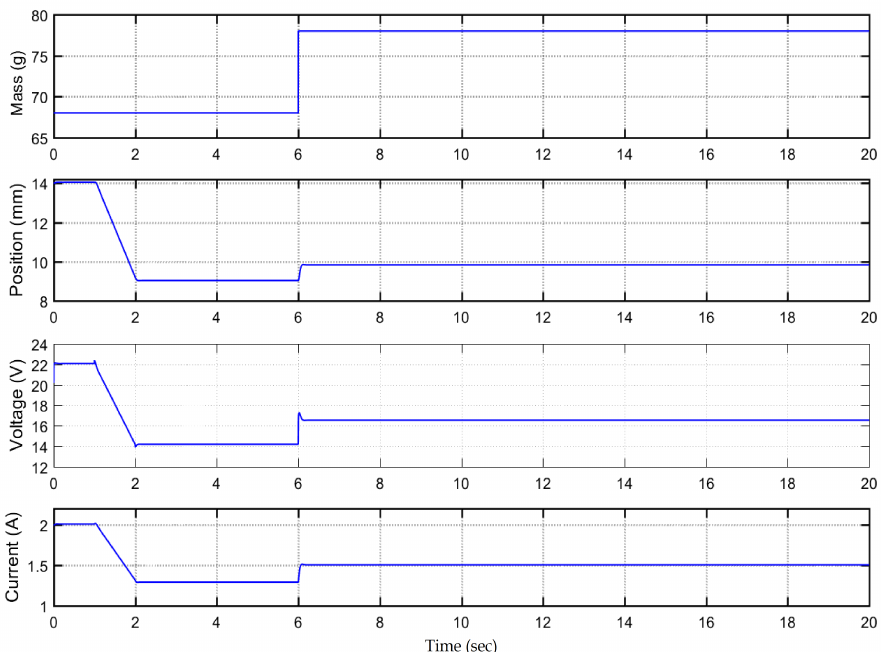
Figure 7. Response of coil voltage, coil current with sudden drop of 15% in mass of steel